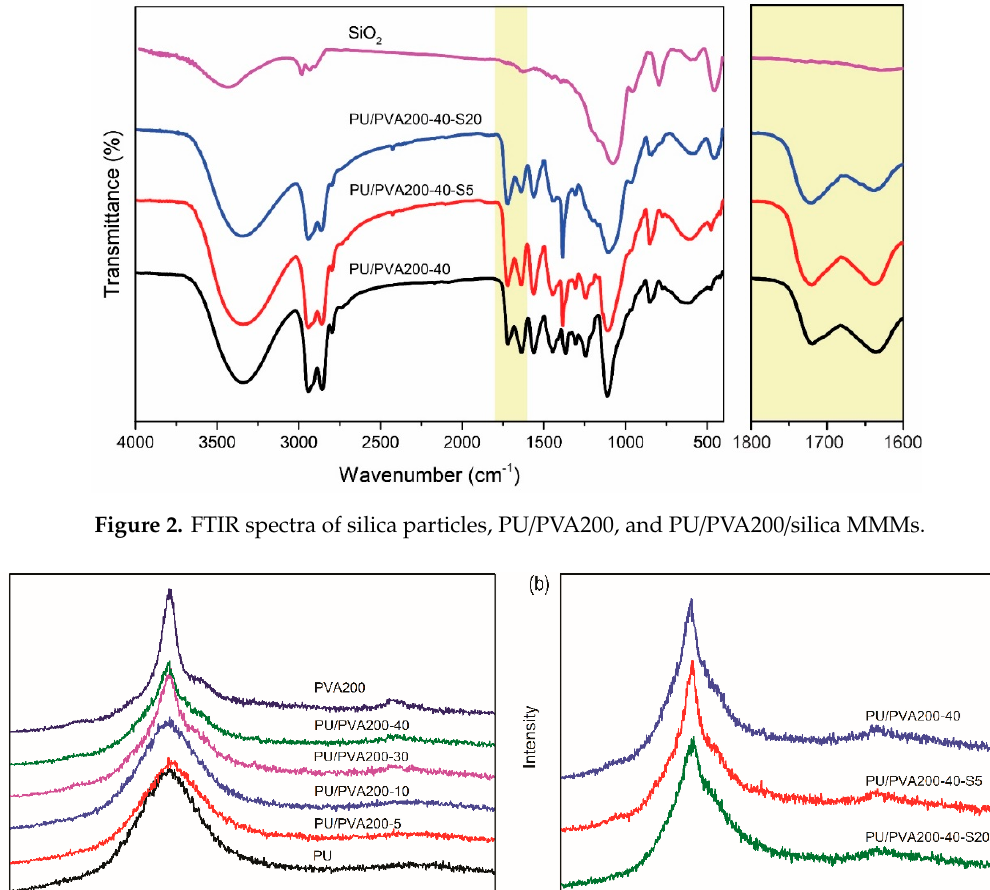
Figure 3. X-ray profiles of ( a ) PU, PVA200, and PU/PVA200 blends and ( b ) PU/PVA200/silica mixed-matrix membranes (MMMs).